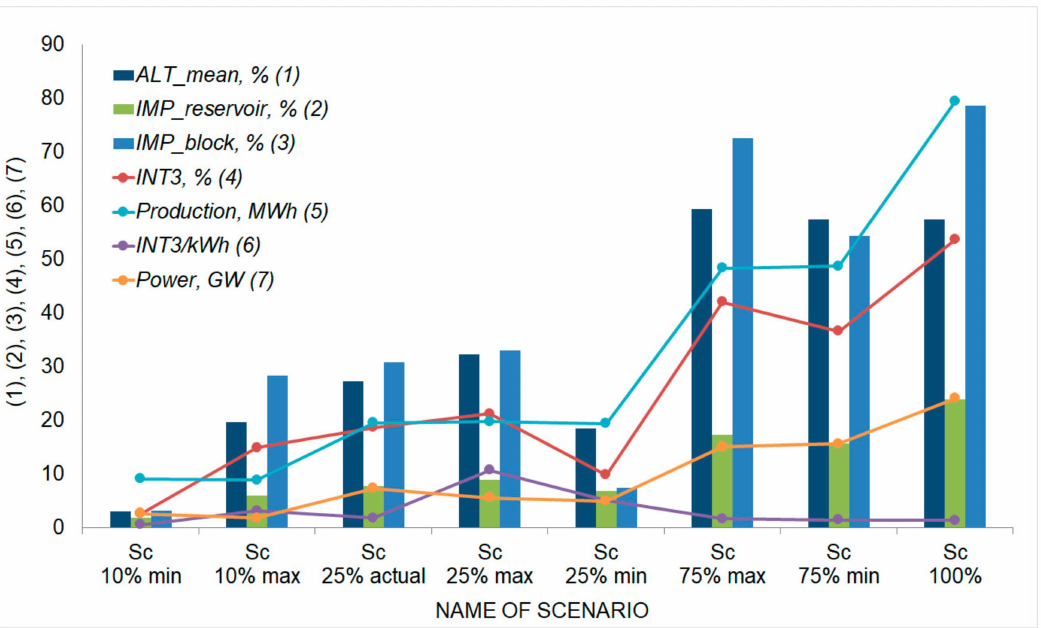
Figure 4. Scenario analysis and the corresponding impact due to di ff erent levels of development of the hydropower potential in the Amur basin.